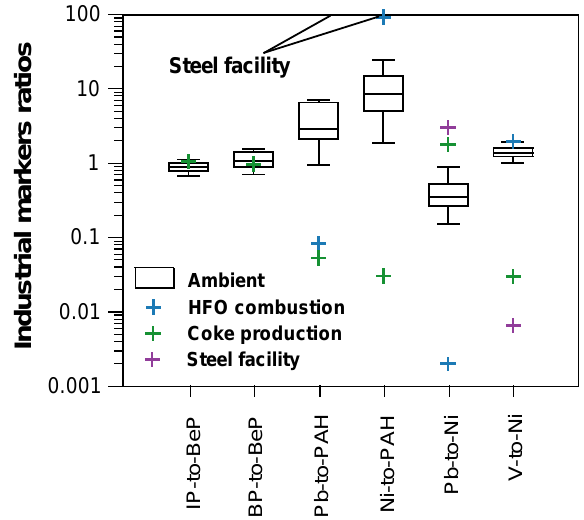
Fig. 4. Ambient ratios between industrial markers (PAH, V, Ni and Fig. 4 Pb) represented as box-and-whisker diagram. The bottom and top of the box denote the lower and upper quartiles, respectively (the 25th and 75th percentile), and the band inside the box is the me- dian (the 50th percentile). The ends of the whiskers refer to the 8th percentile and the 92nd percentile. For comparison, emission ratios are also shown for different industrial sources: HFO com- bustion/shipping (Agrawal et al., 2008; Rogge et al., 1997b), coke production (Weitkamp et al., 2005) and steel facility (Tsai et al., 2007). The spacing between the different parts of the box indicates the degree of dispersion and skewness in the data. Non-dispersed ratios point to the predominance of a single source of